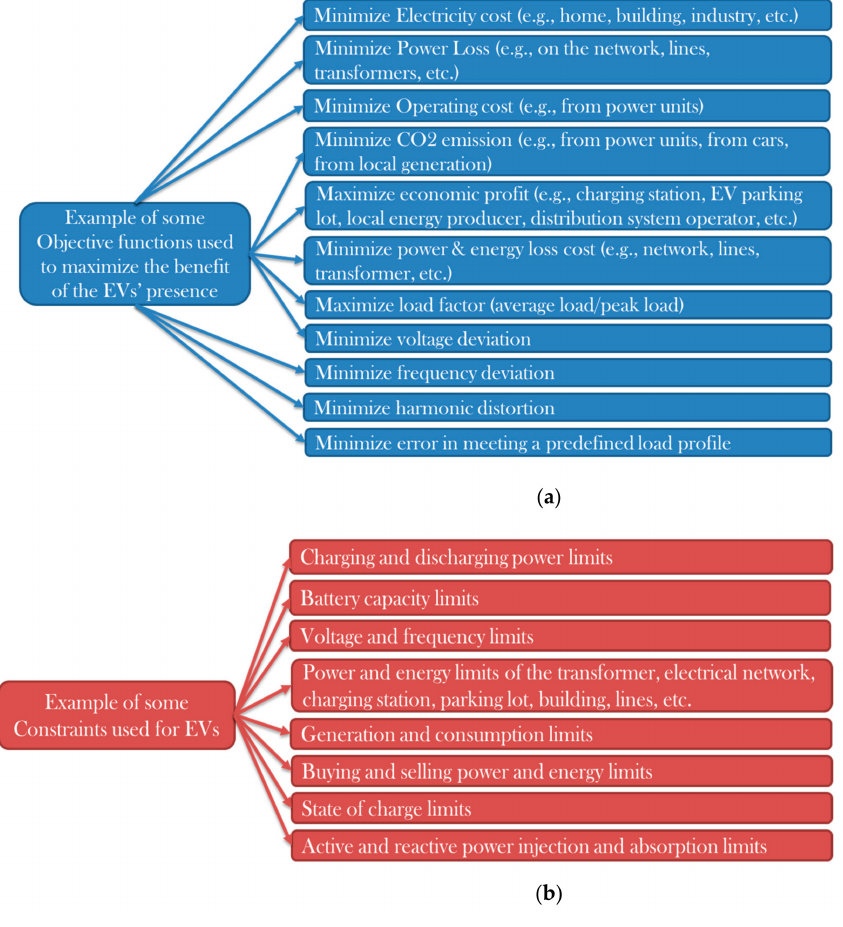
Figure 6. ( a ) Most common objective functions used to maximize the benefit from integrating EVs on the distribution network. ( b ) Sample of main objective functions and constraints used for